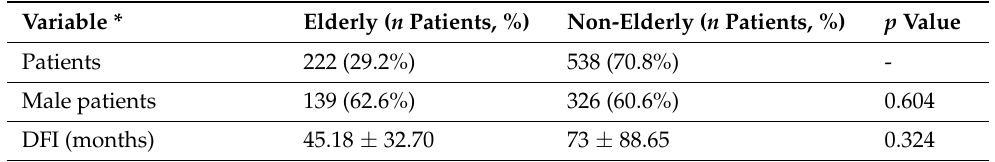
Table 3. Patients’ and surgical